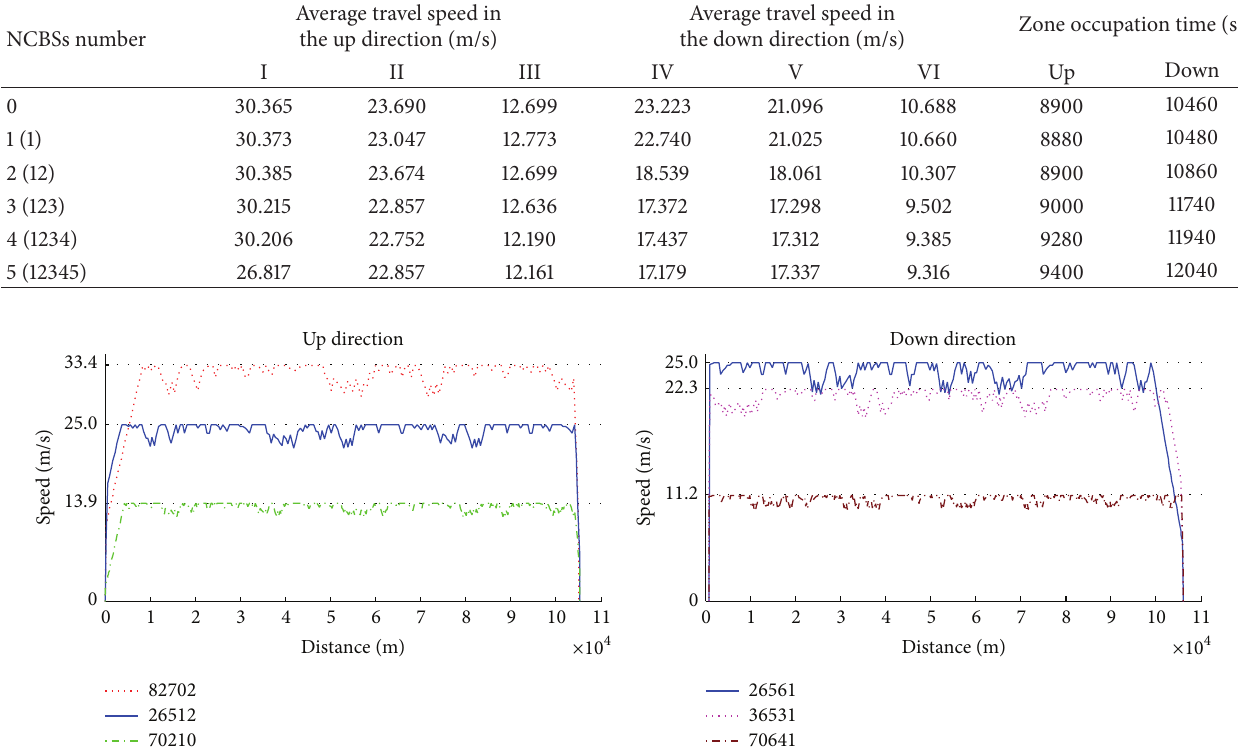
Figure 10: Train speed-distance curve (NCBS number: 0).